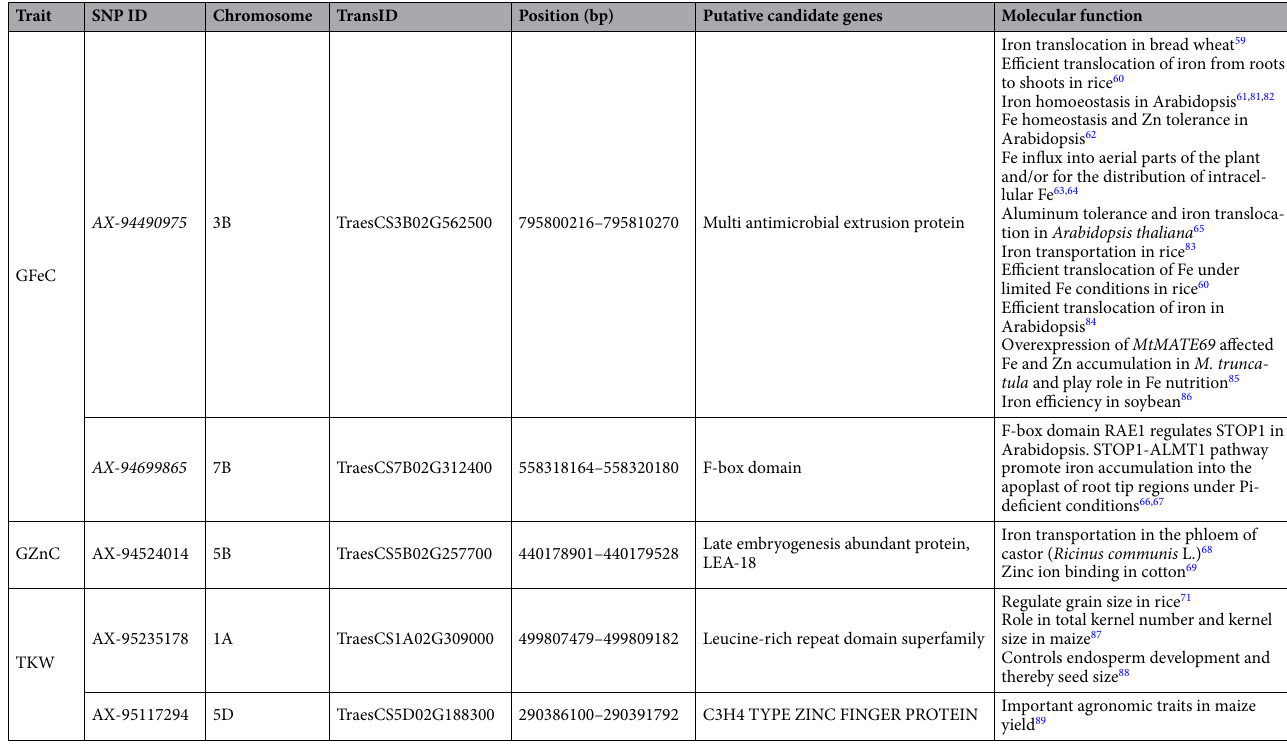
Table 4. Putative candidate genes identified for GFeC, GZnC, and TKW along with their molecular